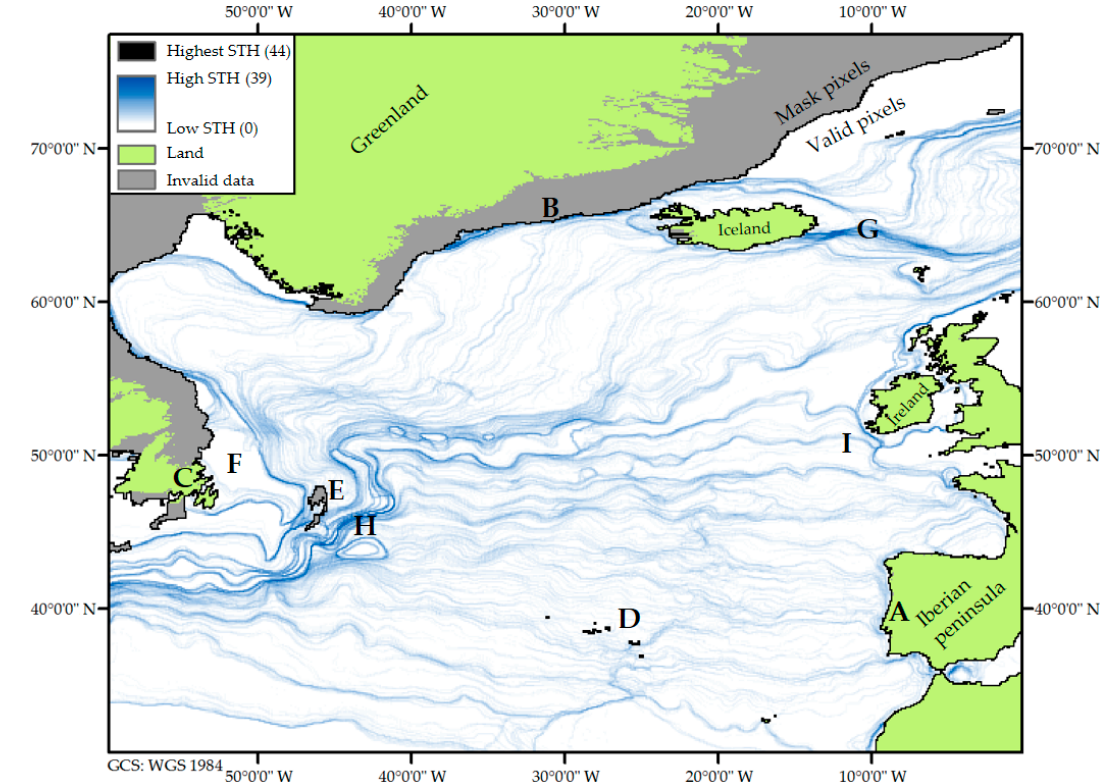
Figure 6. The STH map produced from 2011 data for the region of interest (North Atlantic), with highlighted features. The figure shows the artifacts to expect from the OHMA process, namely the highest STH value (44) for A—coastlines, B—ice/land-linked poor data pixels, C—mixed coastal data and poor data areas, D—islands, and E—isolated poor data areas. It also shows a sample of STH features which are valid pixel estimates, including F—the Northeast Newfoundland Shelf area exhibiting no detectable cluster boundaries (i.e., a spatio-temporally homogeneous region), G—the Iceland and Faroe shelf front region, H—highly heterogeneous waters in and around the Newfoundland Basin, and I—more muted and subtle heterogeneity features in Irish territorial waters.